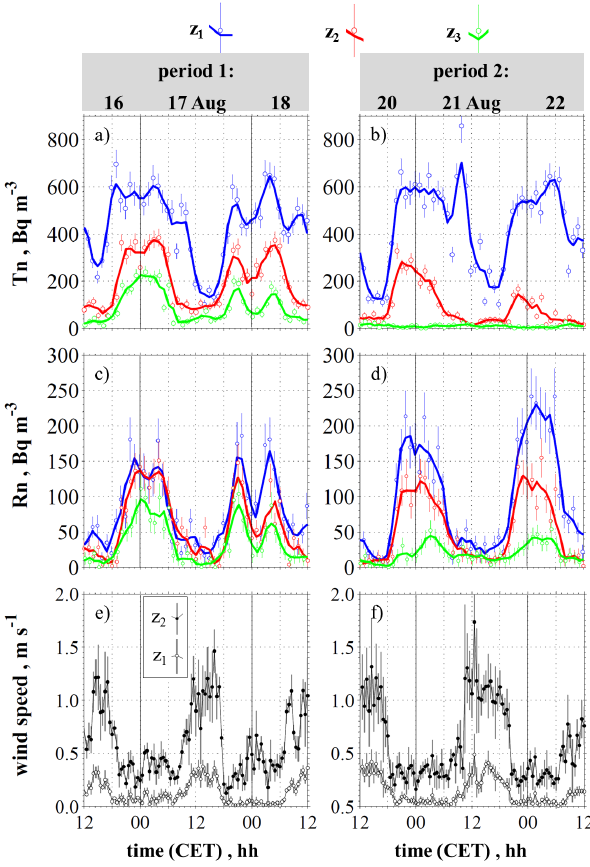
Fig. 8. Tn and Rn concentrations as well as wind speeds ( z 1 = 0 . 2m, z 2 = 0 . 8m) measured during two periods with different inlet height arrangements (period 1: 16–18 August, period 2: 20–22 Au- gust, see Fig. 3). Dots with error bars in plots (a–d) represent the RAD7 concentration readings (integration time 60min) and the cor- responding random errors ( σC) . The solid lines show the running means (width: 3h) of the concentrations. In plots (e) and (f) 30min averages of the measured wind speed are shown, where error bars represent standard